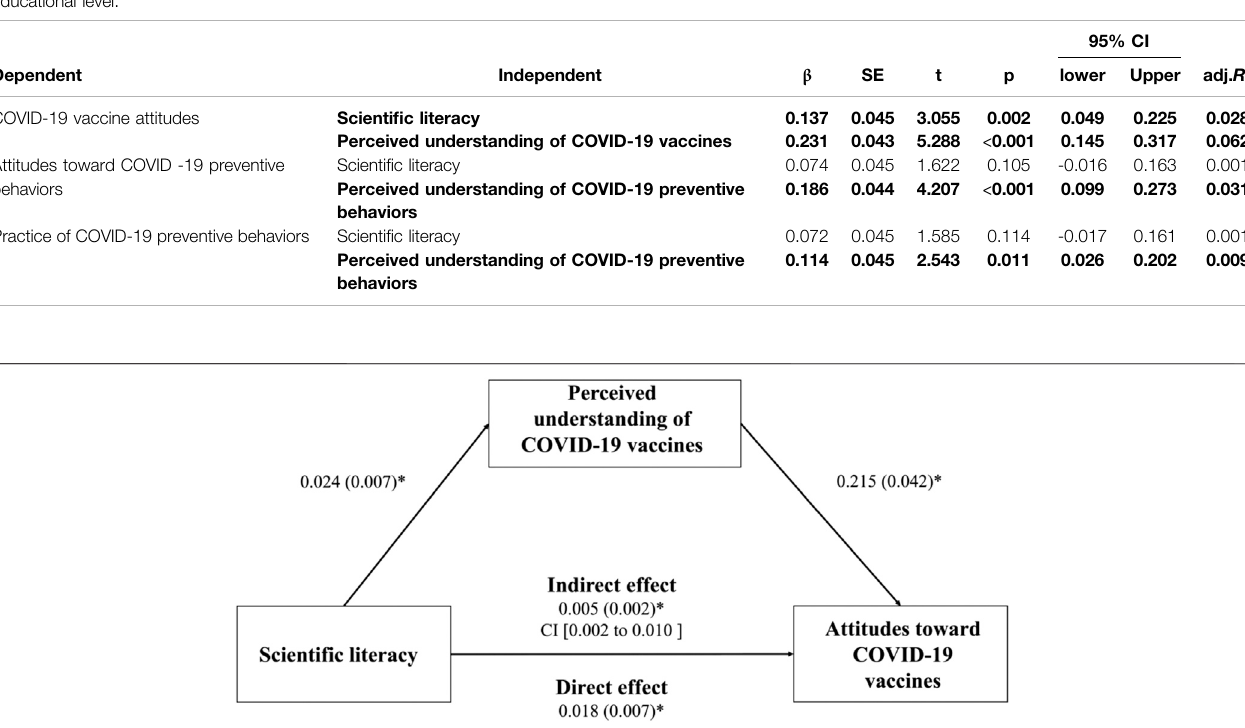
FIGURE 3 | The relations between scienti fi c literacy and attitudes toward COVID-19 vaccines mediated by perceived understanding of COVID-19 vaccines. Unstandardized coef fi cients are displayed. Standard errors are represented in parentheses. * p < 0.05.